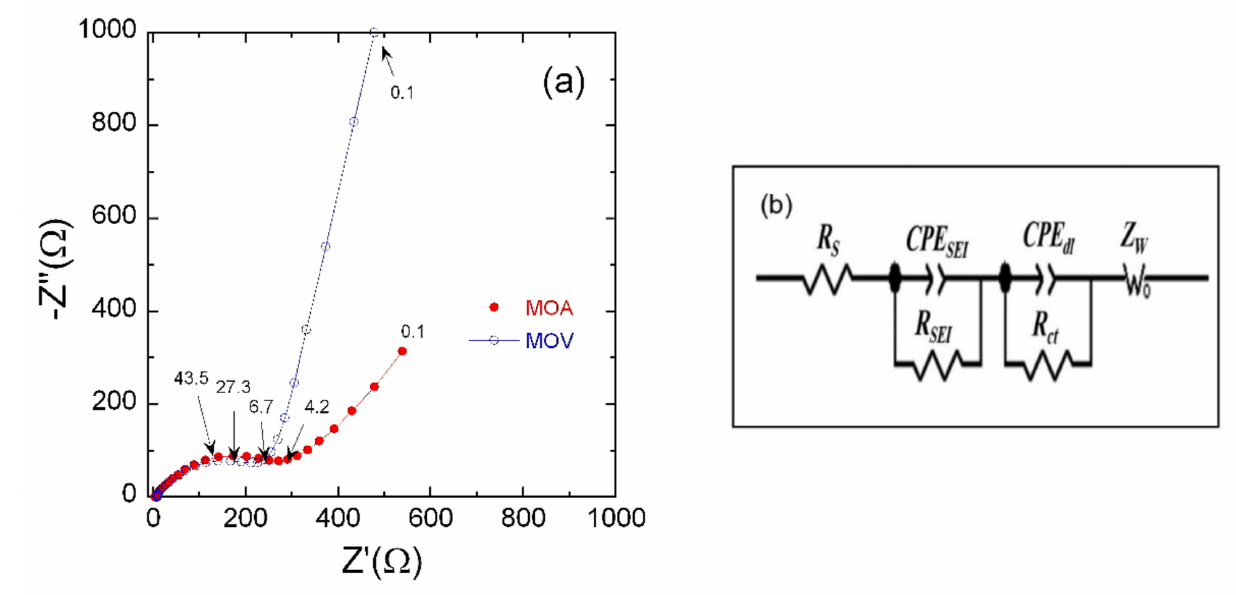
Figure 9. ( a ) Nyquist plots of fresh cells including the MOA and MOV electrodes. ( b ) The equivalent circuit model used for EIS data